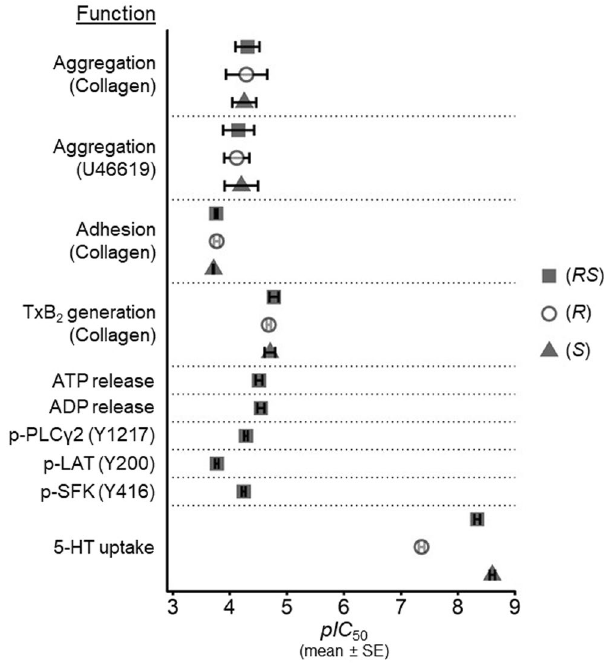
Figure 8. Summary results, showing the difference in pIC 50 values (mean ± SE) between the inhibition of 5-HT uptake by citalopram isomers (Fig. 6) and their inhibition of platelet aggregation (Fig. 1), adhesion to Horm collagen (Fig. 2), TxB 2 generation (Fig. 3), nucleotide release from dense granules (Fig. 4) and the site-specific phosphorylation of Src family kinases (SFK), LAT and PLC γ 2 (Fig.